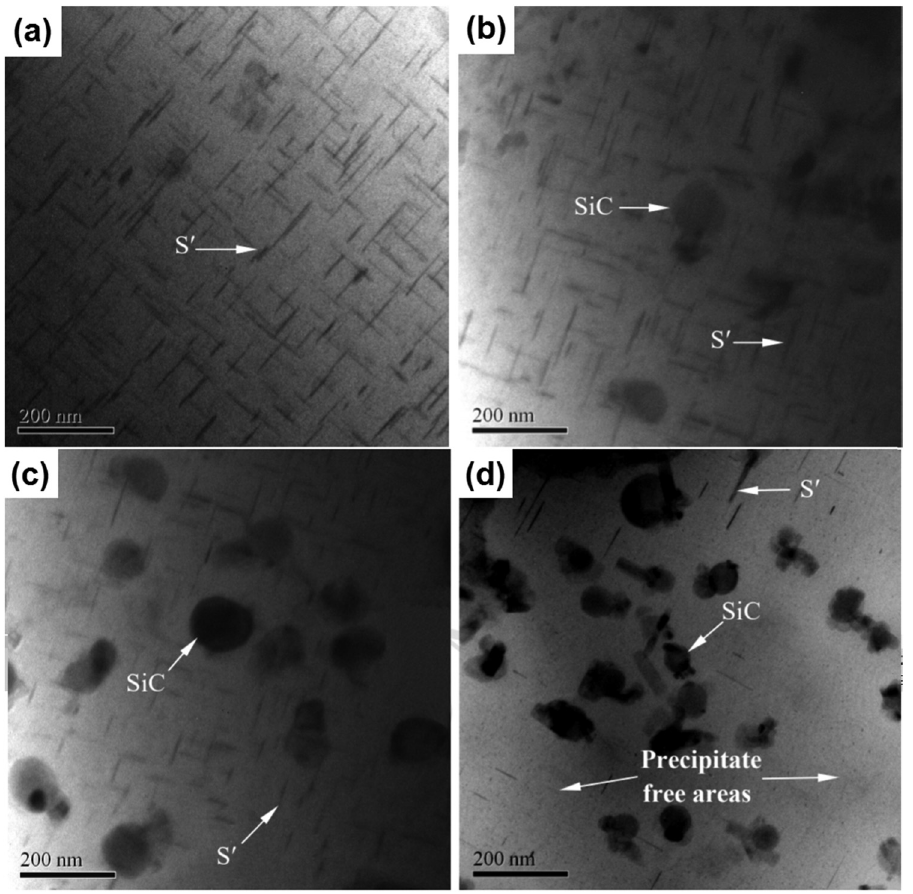
Figure 6: TEM images of a 2024 aluminum alloy reinforced with ( a ) 0, ( b ) 5 wt%, ( c ) 10 wt%, and ( d ) 15 wt% of SiC, after being initially aged at 110°C for 8 h, and then aged at 190°C for 24 h. S ′ precipitates and SiC reinforcements can be observed ( Reproduced with permission from [ 112 ] . )